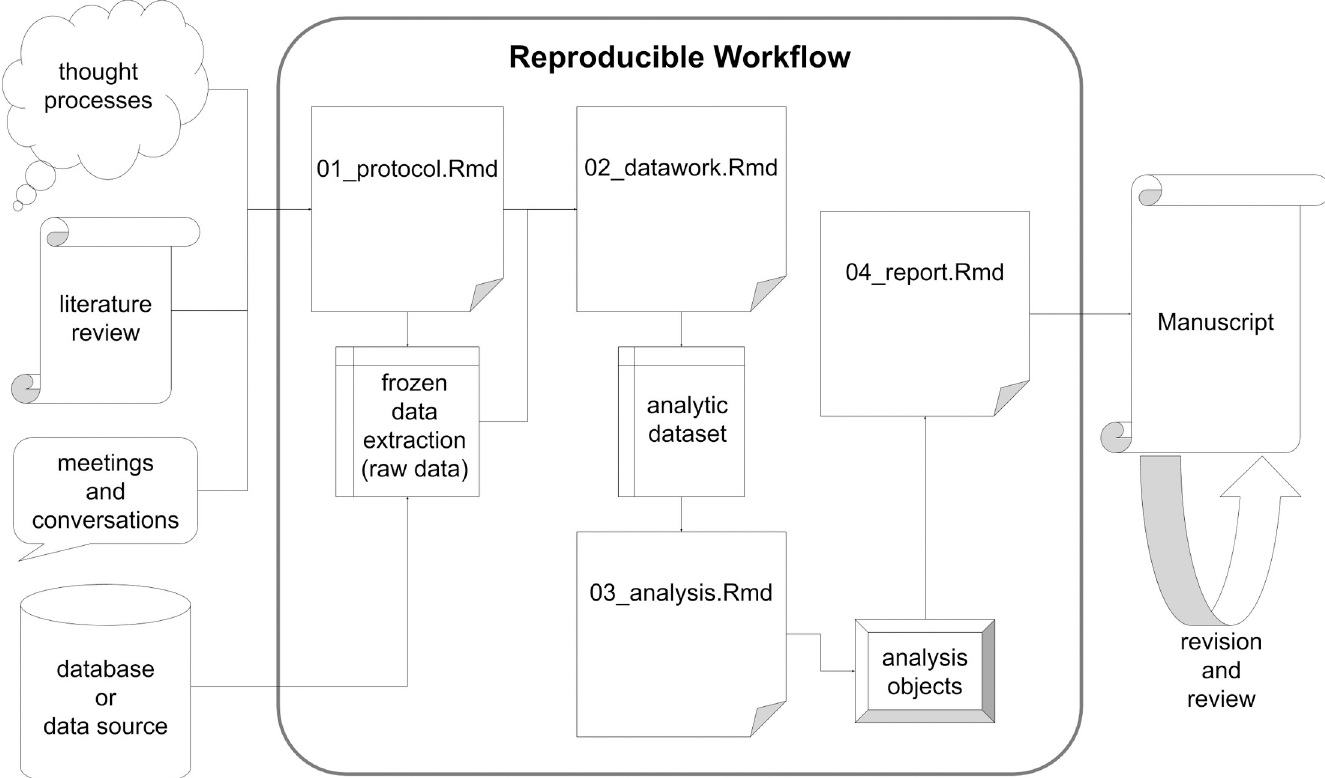
Fig 1. The entire workflow of manuscript creation with the reproducible portions